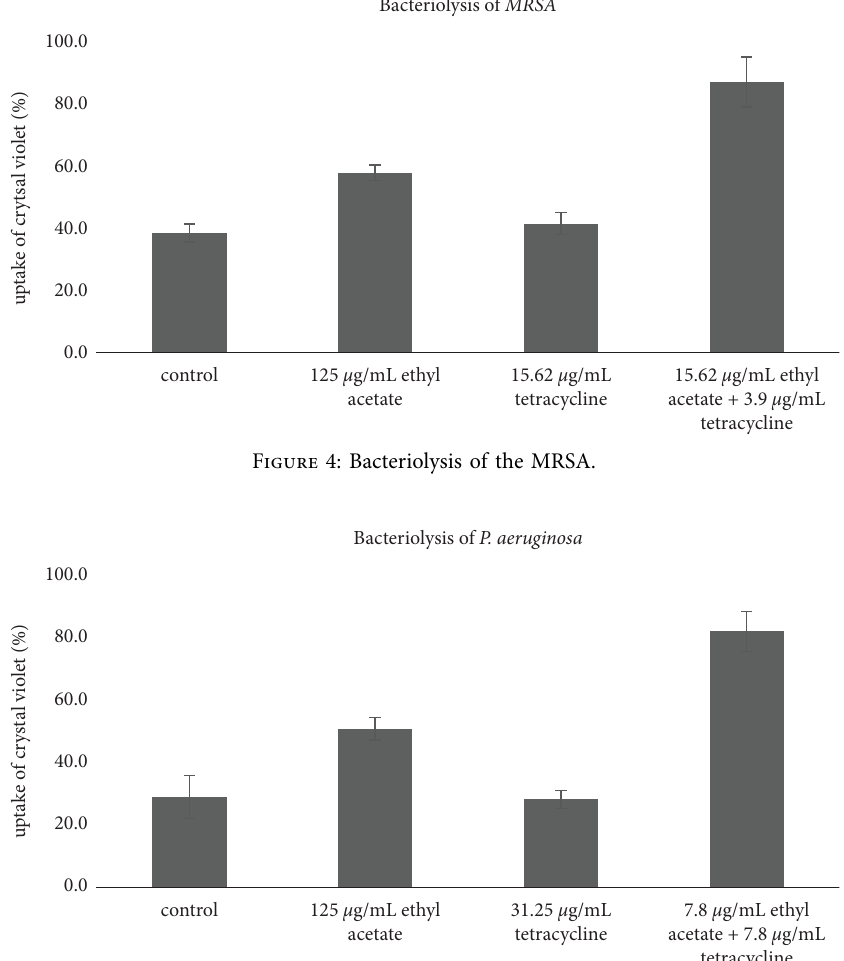
Figure 4: Bacteriolysis of the MRSA.